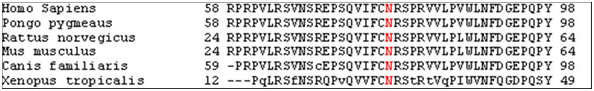
Multiple sequence alignment of VHL protein. The Asn78 amino acid is shown in red. Asparagine amino acid in this position is highly conserved among different species.